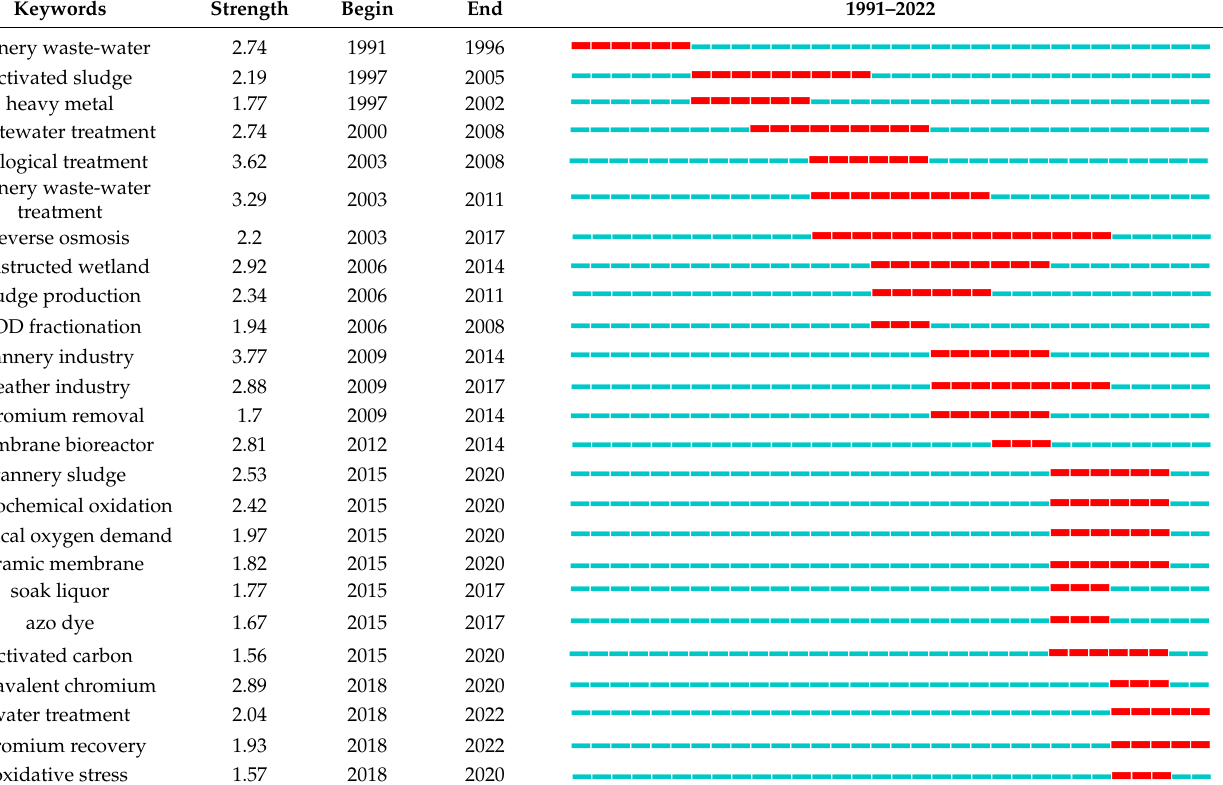
Table 6. The top 25 keywords with the highest number of citation bursts are listed below (red bars indicate keywords that have been referenced frequently; blue bars show keywords that have been cited infrequently). There is a clear indication of the time interval and burst strength of the key- words. “Year” refers to the time of the first occurrence of the mutation in the retrieval record, “Strength” refers to the intensity of the mutation, “Begin” refers to the time of the beginning of the mutation and “End” refers to the time of the ending of the mutation. “Strength” refers to the inten- sity of the mutation. (For interpretation of the references to color in this figure legend, the reader is referred to the Web version of this article.).